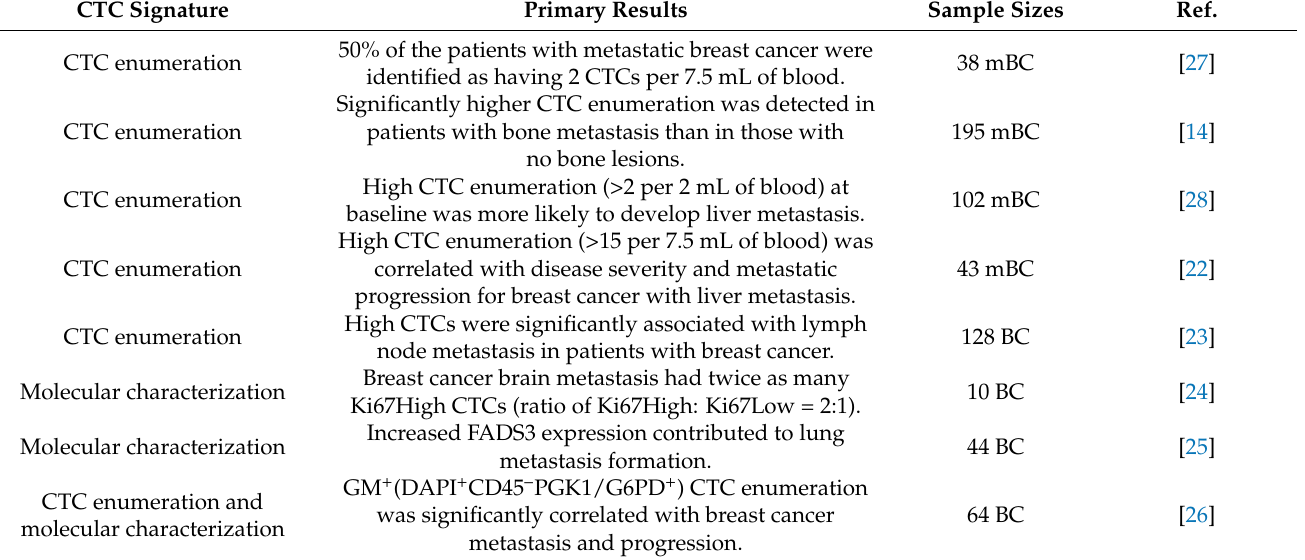
Table 1. Recent studies on the association between CTCs and breast cancer metastasis.